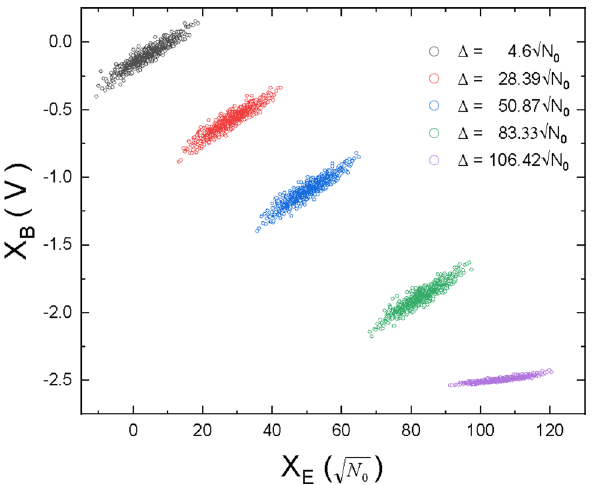
Figure 2. Response of homodyne output due to displacement. Input signal sent by Eve, with quadrature variance Var ( X E ) = 22 N 0 with 5 different displacement (cid:31) values equals to 4.6 √ √ 50.87 N 0 (blue), 83.33 N 0 (green) and saturation at 106.42 quadrature measurement X B (expressed here in volts). Large displacement value can lead to saturation (that occurs when X B reaches − 2.5